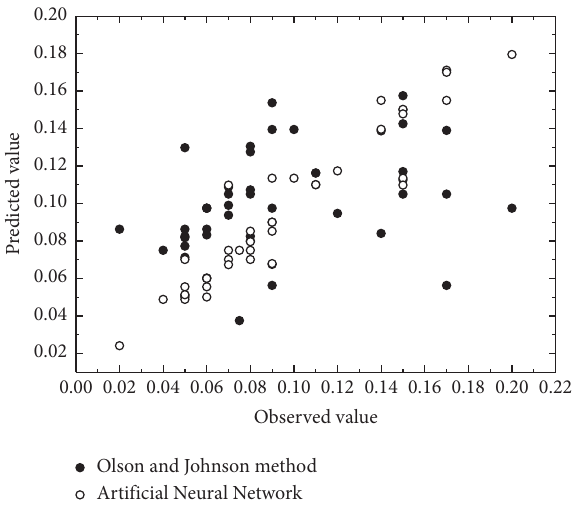
Figure 4: The predicted values by Artificial Neural Network model and Olson and Johnson method